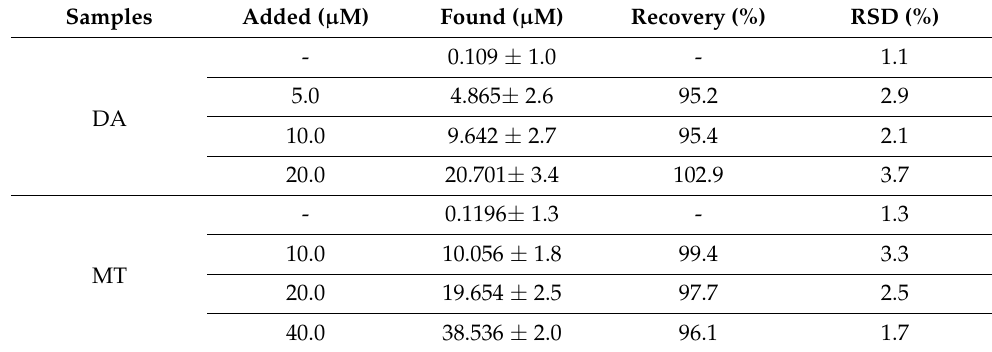
Table 2. Comparison of DA and MT concentrations measured in human serum samples. Samples Added ( µ M) Found ( µ M) Recovery (%) RSD